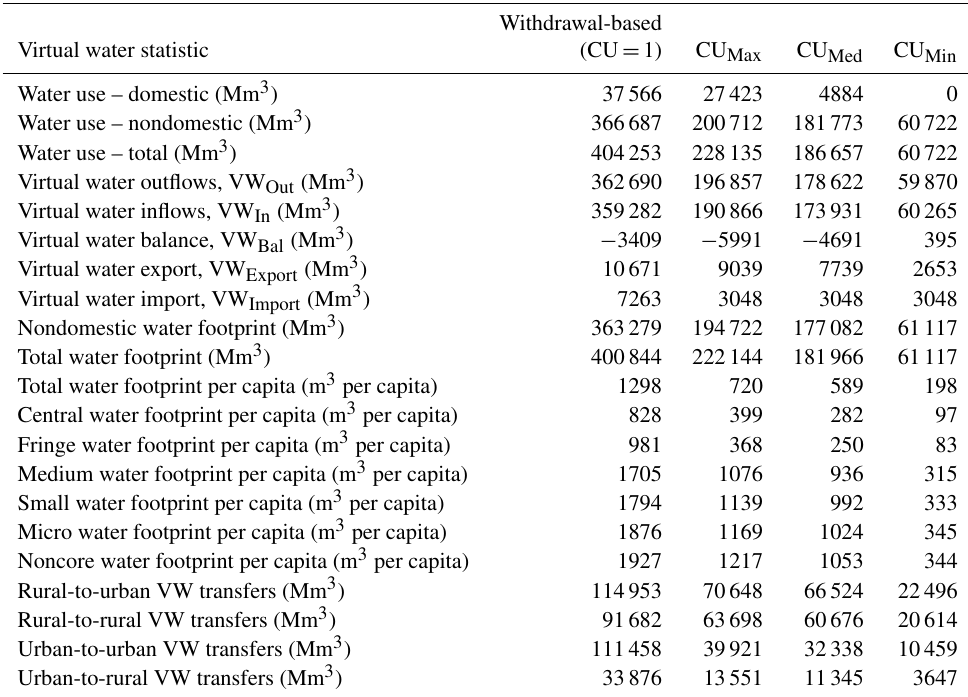
Table 2. US water footprint and virtual water statistics.